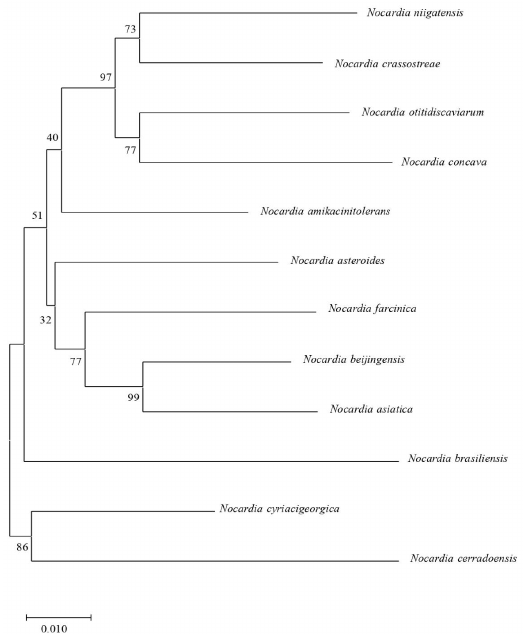
Figure 4. A phylogenetic neighbor-joining tree including these 12 types of strains as an indicator and the 77 clinical strains studied in the nine years based on the MLSA concatenated sequence.